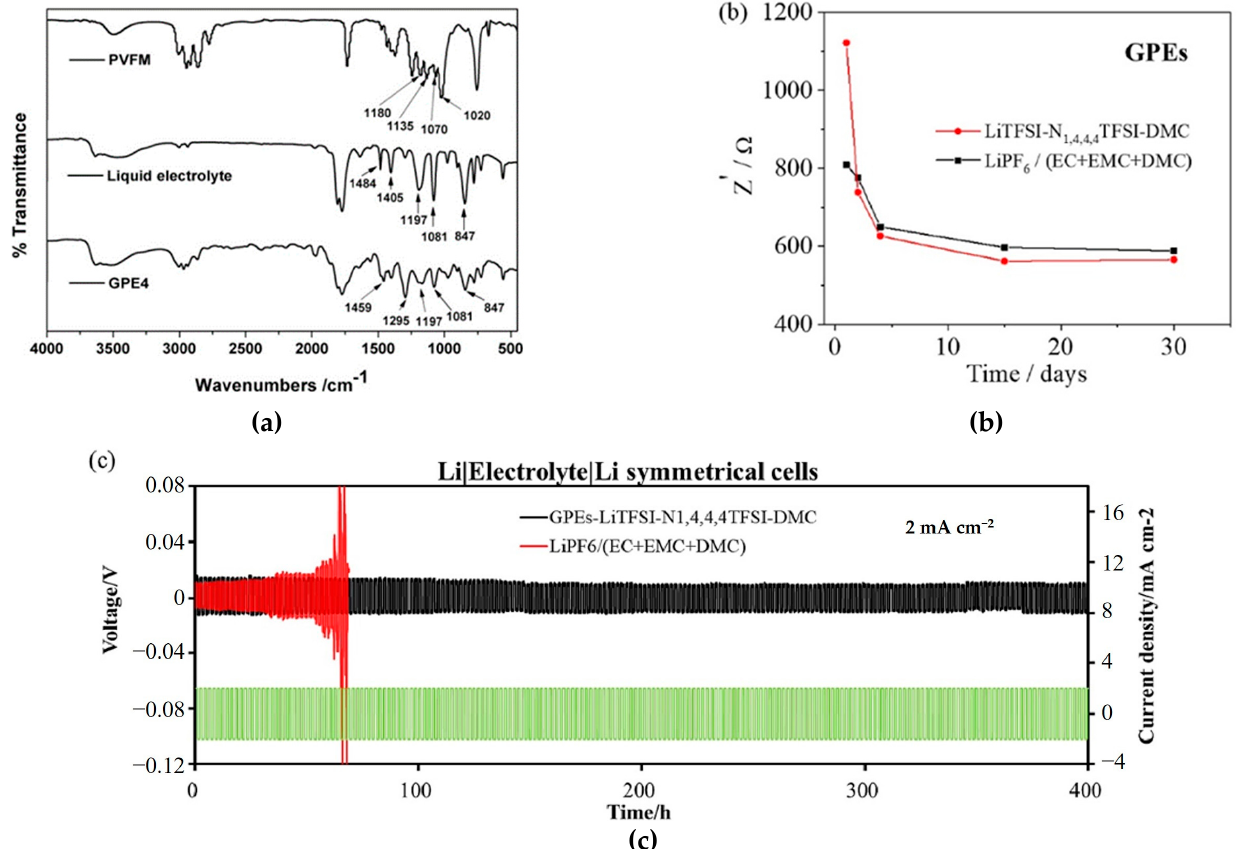
Figure 4. ( a ) FT-IR spectra of PVFM, liquid electrolyte [92], Copyright ® 2014, Elsevier B. V.; ( b ) Evolution of the interfacial resistance and ( c ) voltage profiles of Li plating/stripping at a current density of 2 mA cm − 2 . Reprinted/adapted with permission from Ref. [93]. Copyright ® 2021, Elsevier B. V. GPEs, which have high ionic conductivity of 6.15 × 10 − 3 S cm − 1 and outstanding Li + transference number of 0.59 at 25 ◦ C, were fabricated using trimethylolpropane